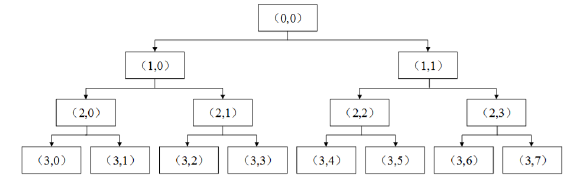
Fig. 5. Node number of wavelet packet decomposition tree struction of a power signal were used to divide a